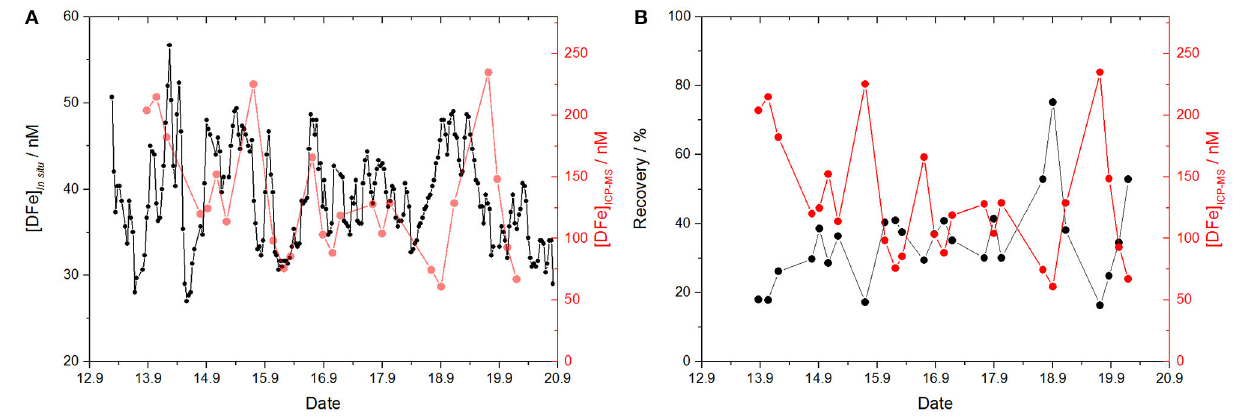
FIGURE 7 | (A) Time series of the DFe in situ measurements (black, as FZ labile Fe) and discrete samples analyzed via ICP-MS (red). Note the different scales of the y-axes. (B) The analyzer’s recovery (black) together with [DFe] ICP − MS (red). For recovery calculations the moving average of the two closest in situ data points to each discrete sample was